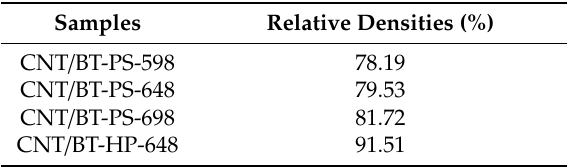
Table 1. Relative densities of the as-prepared bulk composites.